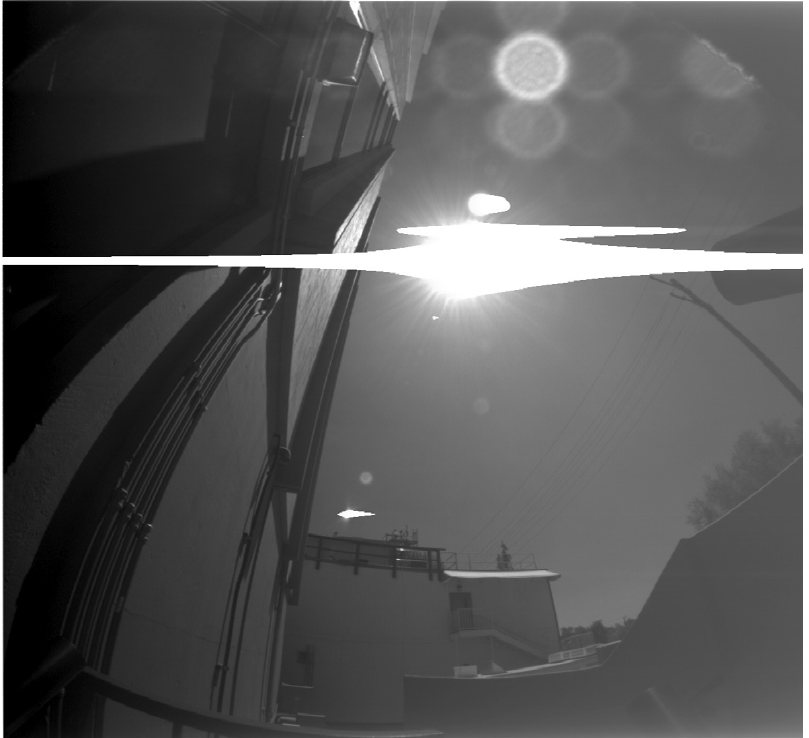
Figure 10. Outdoor testing of MER EM HazCam shows need for optical redesign for RDS-SkyCam. Analysis of the test results determined that an internal, reflective ND1.1